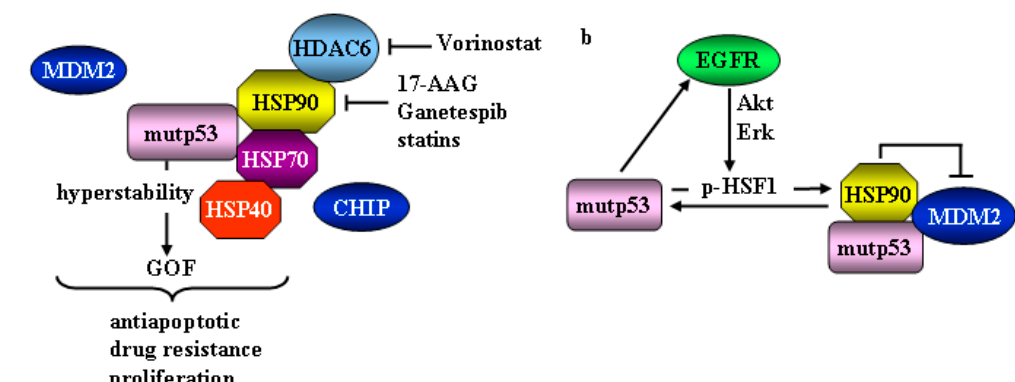
Figure 1. Mutant p53 and heat shock proteins (HSP) machinery. ( a ) Mutp53 protein binds the